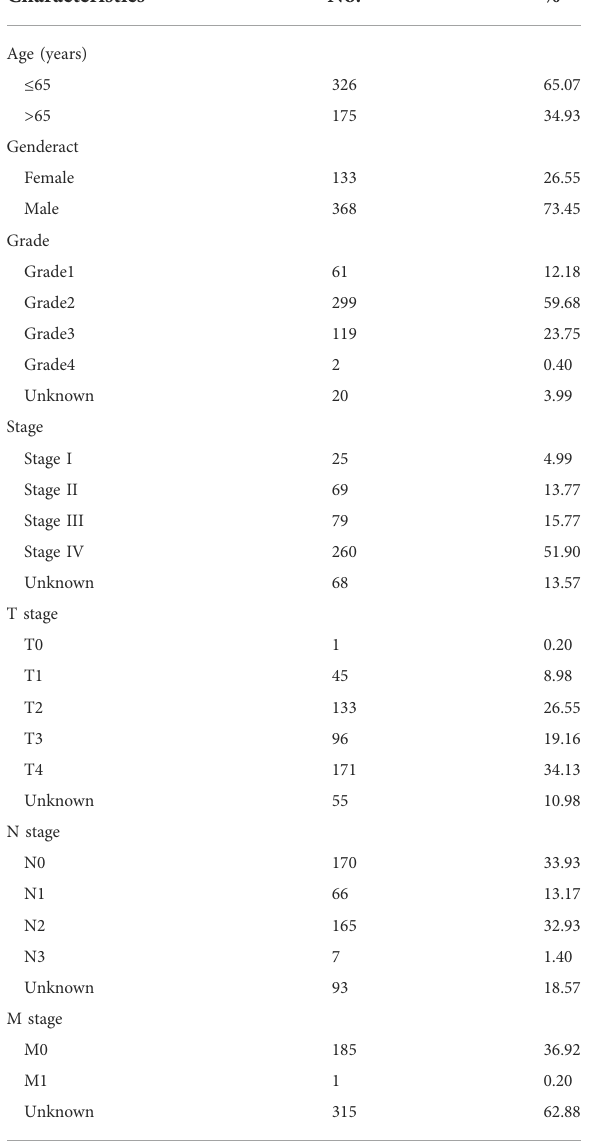
TABLE 1 Demographic and clinicopathological characteristics of patients with HNSCC ( n = 501).